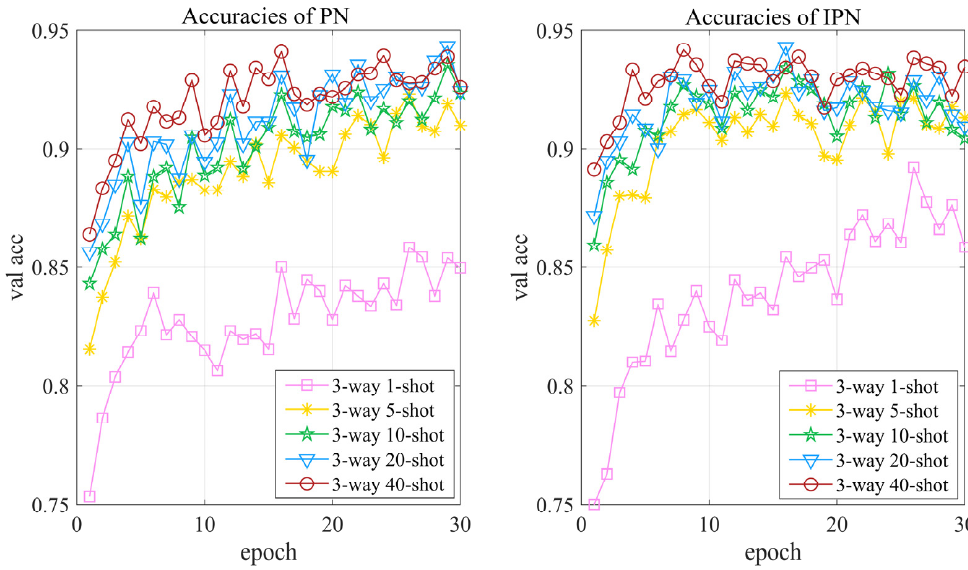
Figure 9. Validation accuracy of PN and IPN with different support set samples. Table 7. Classification accuracy on closed-set few-shot recognition with different support set samples.